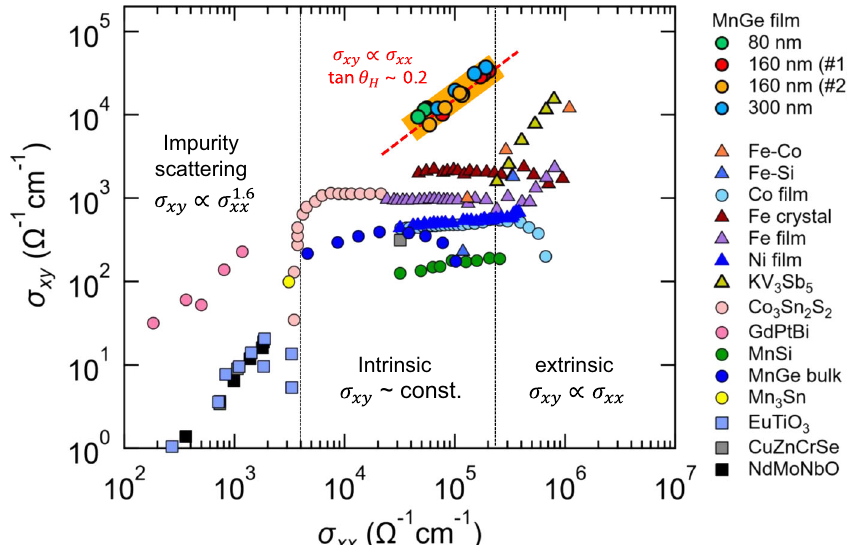
Fig. 4 Full logarithmic plot of σ xy versus σ xx for various materials. The shaded region with a red dashed line indicates a linear relation ( σ xy / σ xx ) in MnGe thin fi lms with a giant Hall angle reaching 18 (cid:2) 22 % for the thickness of t = 80, 160, and 300 nm. The data are taken from the peak positions of the Hall angle below 30 K. The large Hall conductivity and the Hall angle realized in MnGe thin fi lms result in a clear deviation from the conventional scaling plots established for ferromagnets 2,16,17 . The reported data for other materials are cited from literature 6,7,14,16,17,20,27,38 – 40